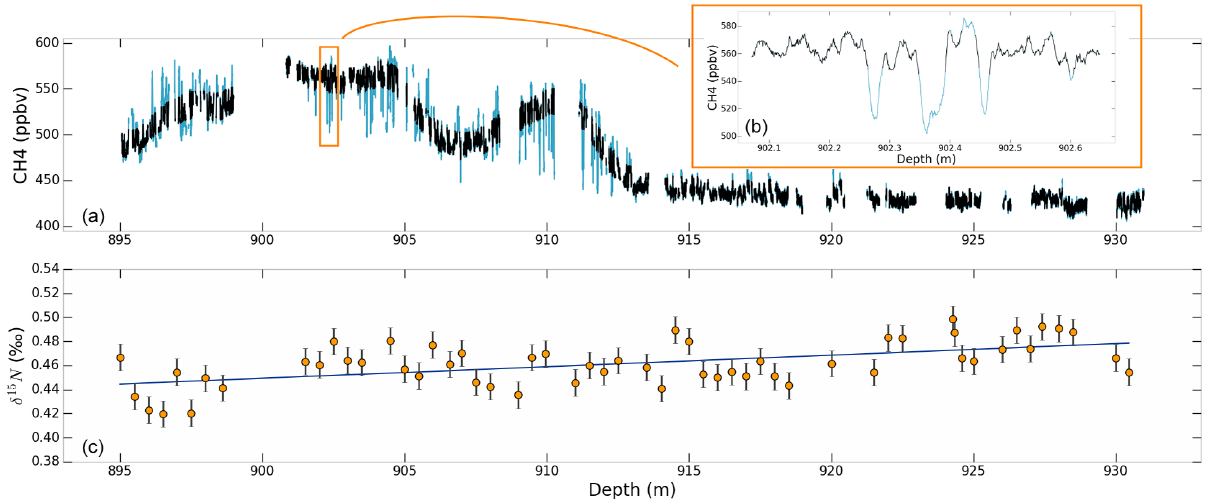
Figure 1. (a) Methane concentration along the Vostok 4G-2 ice core. In blue: data cleaned from ambient air and kerosene contamination and calibrated. In black: data cleaned from layered trapping. (b) Zoom of the section from 902 . 0 to 902 . 7m; (c) δ 15 N of N 2 as a function of depth in the Vostok 4G-2 ice core. Orange dots: isotopic measurements. The vertical error bars correspond to the pooled standard deviation. In blue: linear